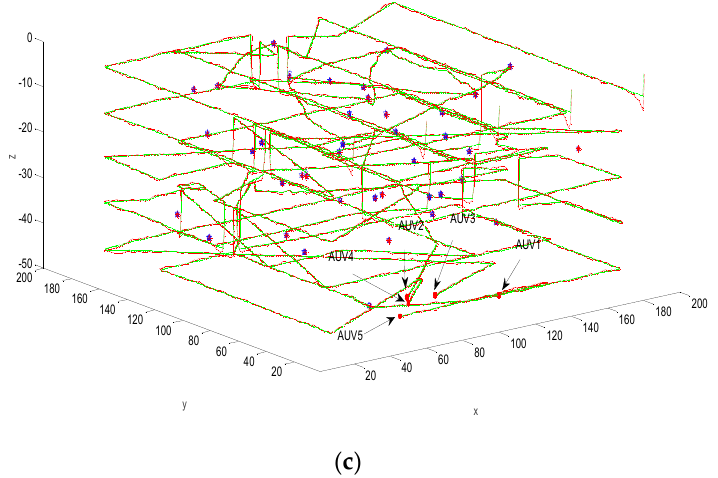
Figure 5. Static target search of the autonomous underwater vehicles (AUVs). ( a ) Initial state; ( b ) Search process with static targets; ( c ) The AUV’s last search results.